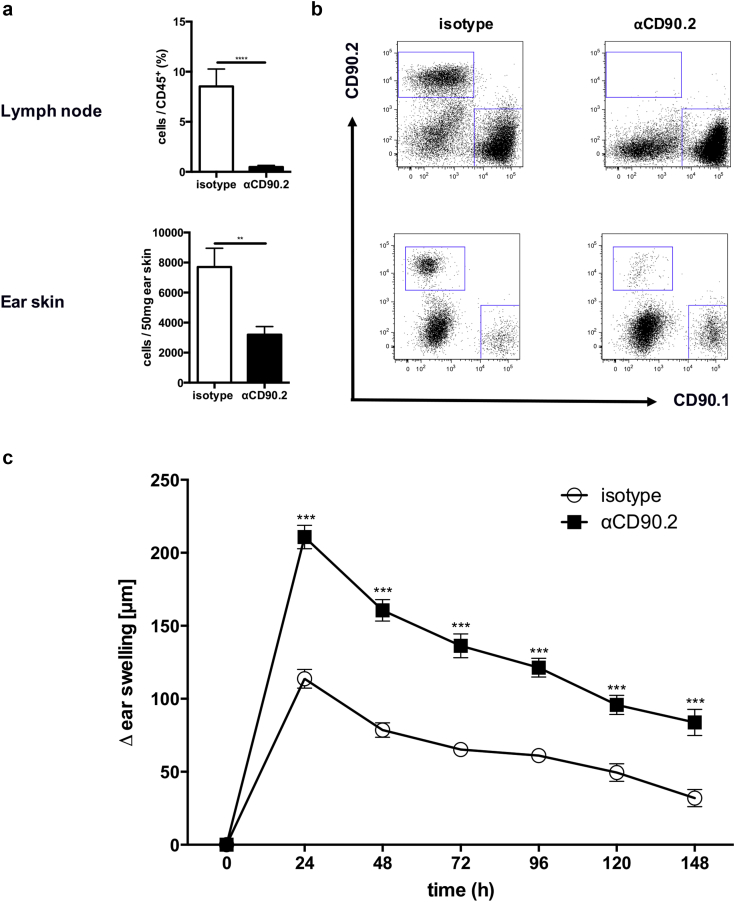
Depletion of all ILC subsets leads to an enhanced ear swelling response. (a) Verification of ILC depletion in ear draining lymph nodes (a, upper panel) and ear skin (a, lower panel) after administering anti-CD90.2 (200 μg) every other day (4 days total) to CD90.2 Rag1–/– recipient mice that were reconstituted with FACS-sorted CD3–, CD8+, and CD4+ T cells from CD90.1+ donor mice. Values in (a) are displayed as absolute cell numbers per 50 mg ear skin and percent age of cells of total leukocytes in the ear draining lymph nodes, respectively. (b) Representative dot plots showing depletion of CD90.2+ leukocytes in ear draining lymph nodes (b, upper panel) and ear skin (b, lower panel). (c) Ear swelling response after the last allergen challenge in ILC-depleted versus isotype-treated mice shown as delta from baseline ear thickness. Data in (a) and (c) are shown as mean ± standard error of the mean, pooled data of three independent experiments with n ≥ 5 mice per group. *P < 0.05, **P < 0.01, ***P < 0.001, and ****P < 0.0001. ILC, innate lymphoid cell.